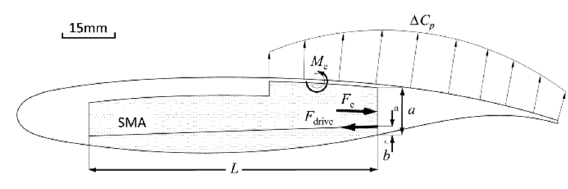
Figure 6. Mechanical model of trailing